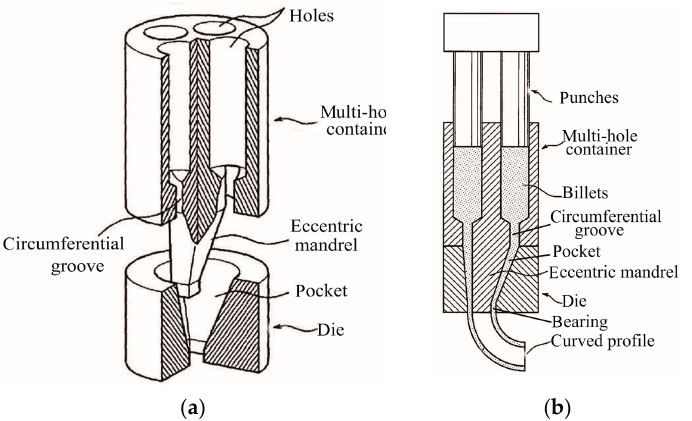
Figure 25. Design of the extrusion die pocket, eccentric mandrel and multi-punch to achieve curved profiles: ( a ) schematic illustration, ( b ) extruded curved profiles [93].